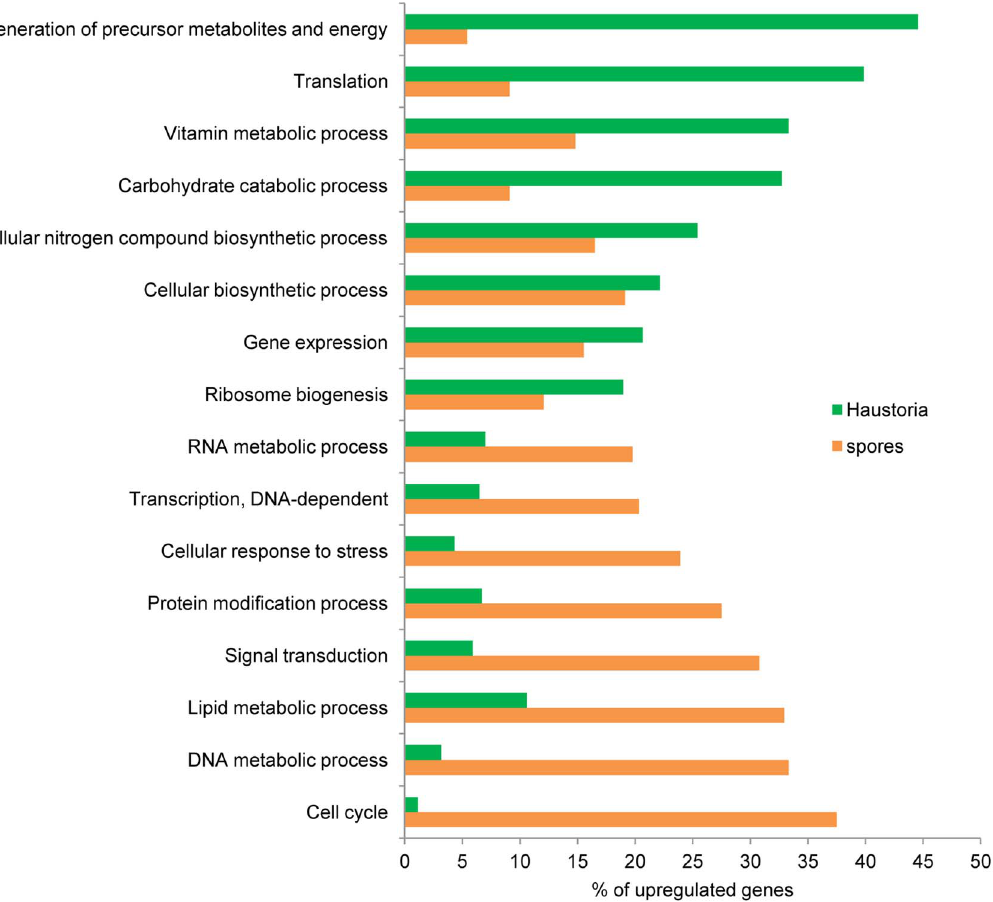
Figure 3. Comparative ontology analysis of transcripts with statistically significant changes in expression between haustoria and germinated spores. Of the original transcript set, 30.2% (601) of the 1,989 haustorial-enriched genes and 47% (1,109) of the 2,357 genes up- regulated in germinated spores were annotated with B2G. Relevant biological process GO terms are shown on the Y-axis. Percentages of genes differentially expressed in each tissue belonging to the nominated categories are shown on the X-axis.